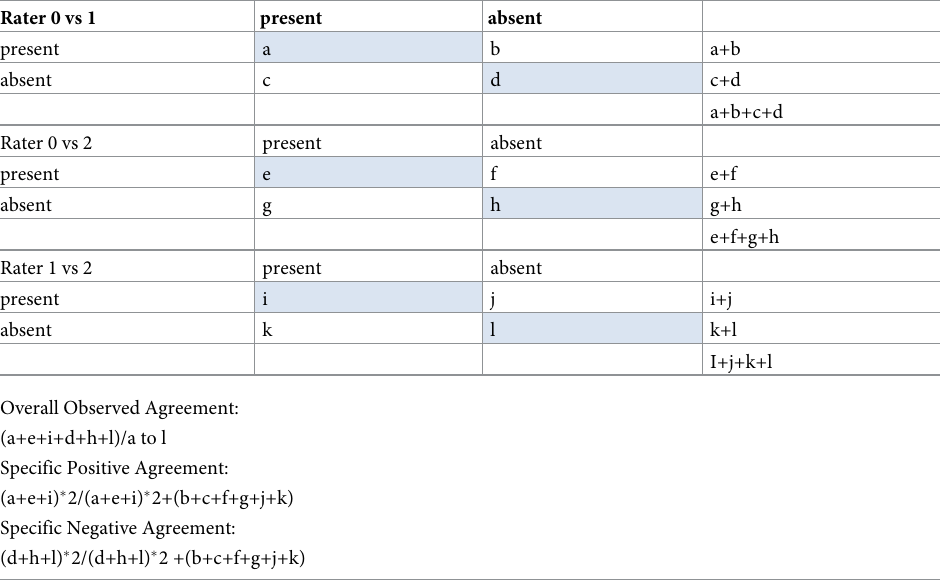
Table 2. Calculation observed agreement for three